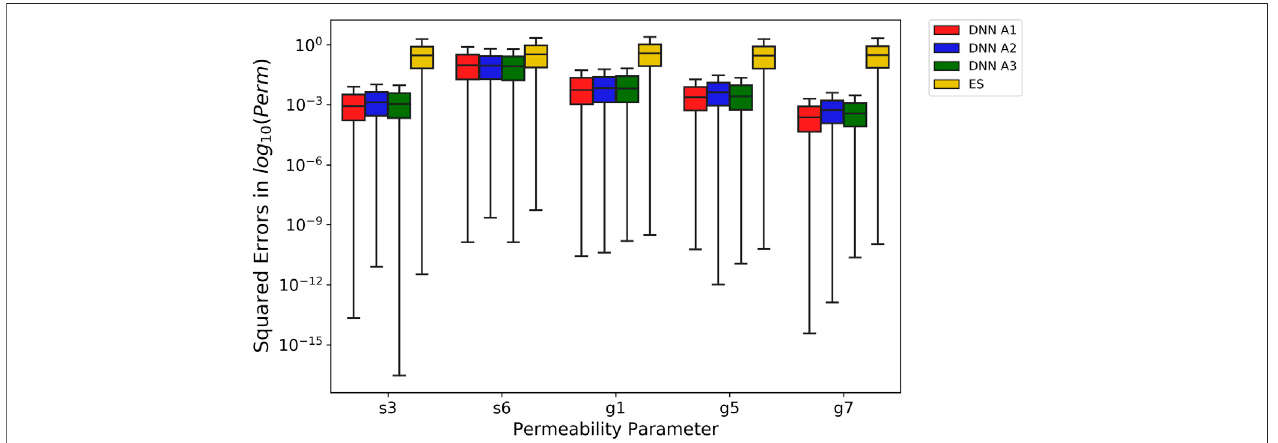
FIGURE 8 | Box plots of squared errors on permeabilities estimated by DNNs and ES for the testing set using relative observation error 0.05. The x -axis is the permeability parameter. The y -axis is the squared errors of the log 10 -transformed permeability parameters. The y -axis is shown in log-scale. The boxplots are fi lled with different colors corresponding to different estimation methods.